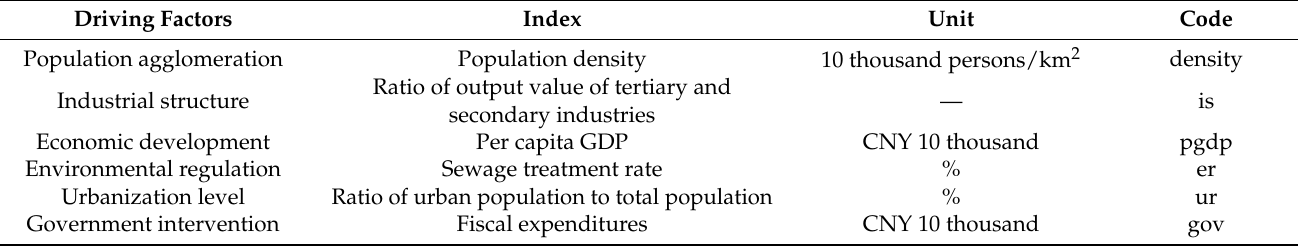
Table 3. Variables of driving factors of the ULGUE in Lanzhou-Xining urban